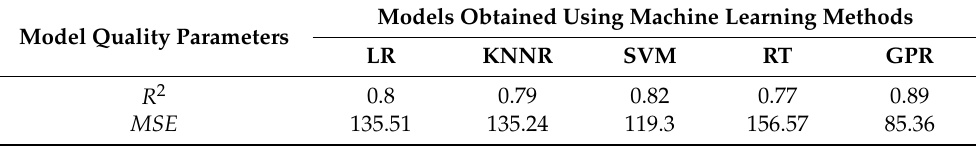
Table 3. Quality parameters of the models obtained using machine learning methods. Model Quality